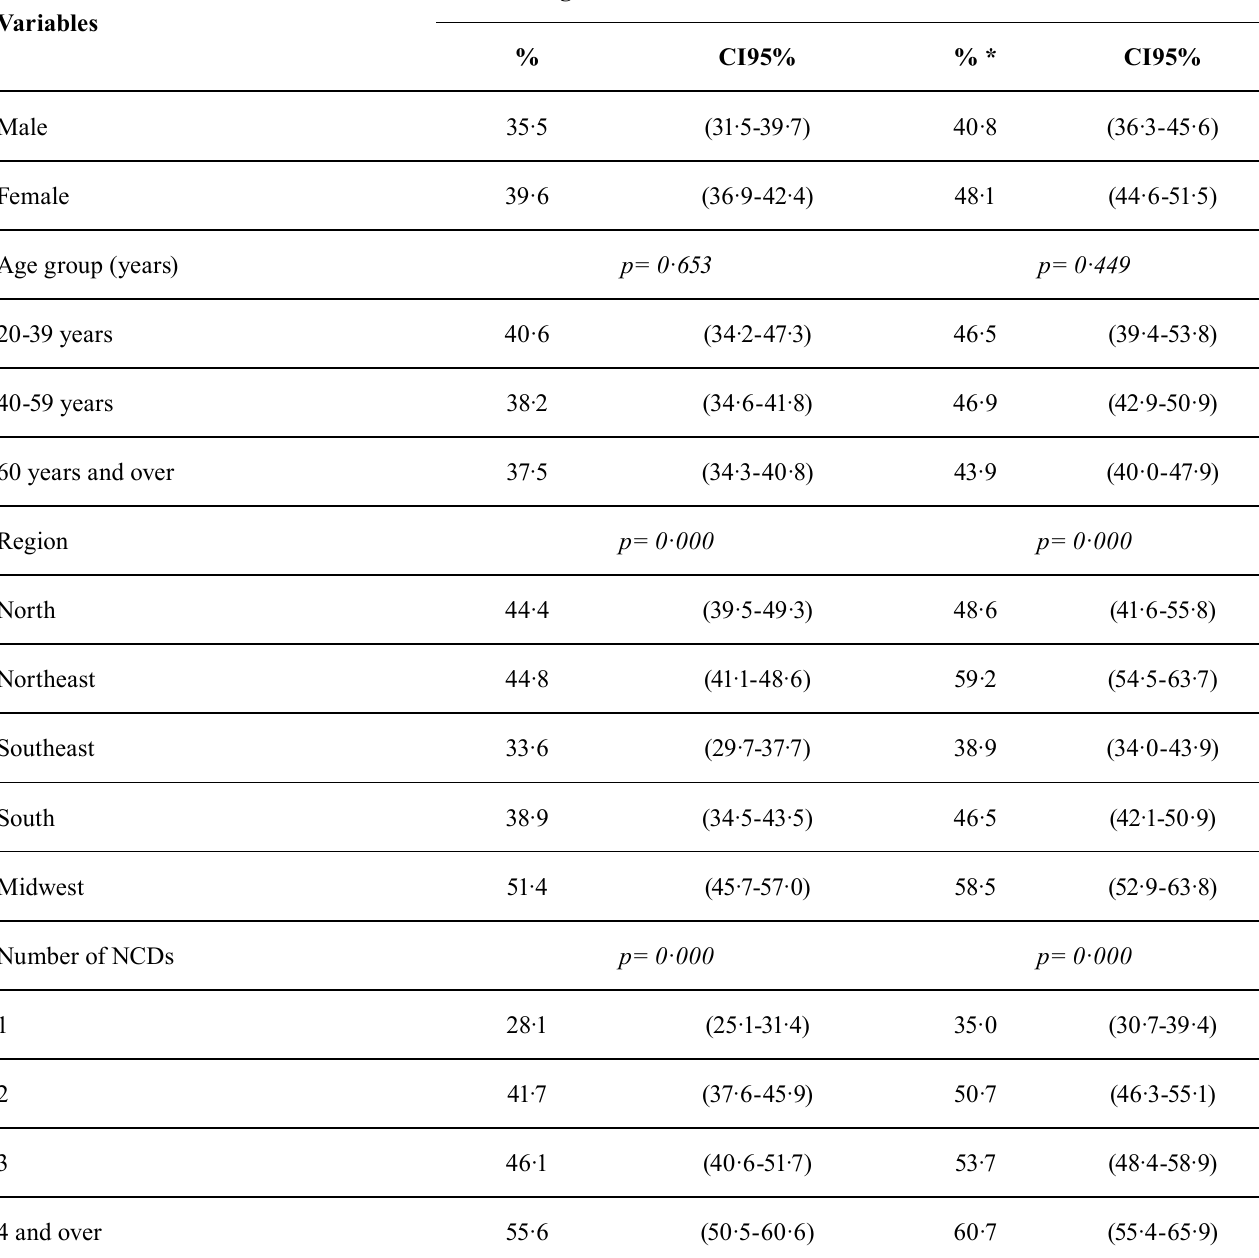
TABLE III – Difficulties of availability of medicines in SUS pharmacy services among adult and elderly (20 years and over) users of the Unified Health System (SUS) with a reported chronic non-communicable disease (NCD), indication of medicine treatment and that obtain some of the medicines in use in the SUS, according to demographic, socioeconomic and health variables. PNAUM, 2014